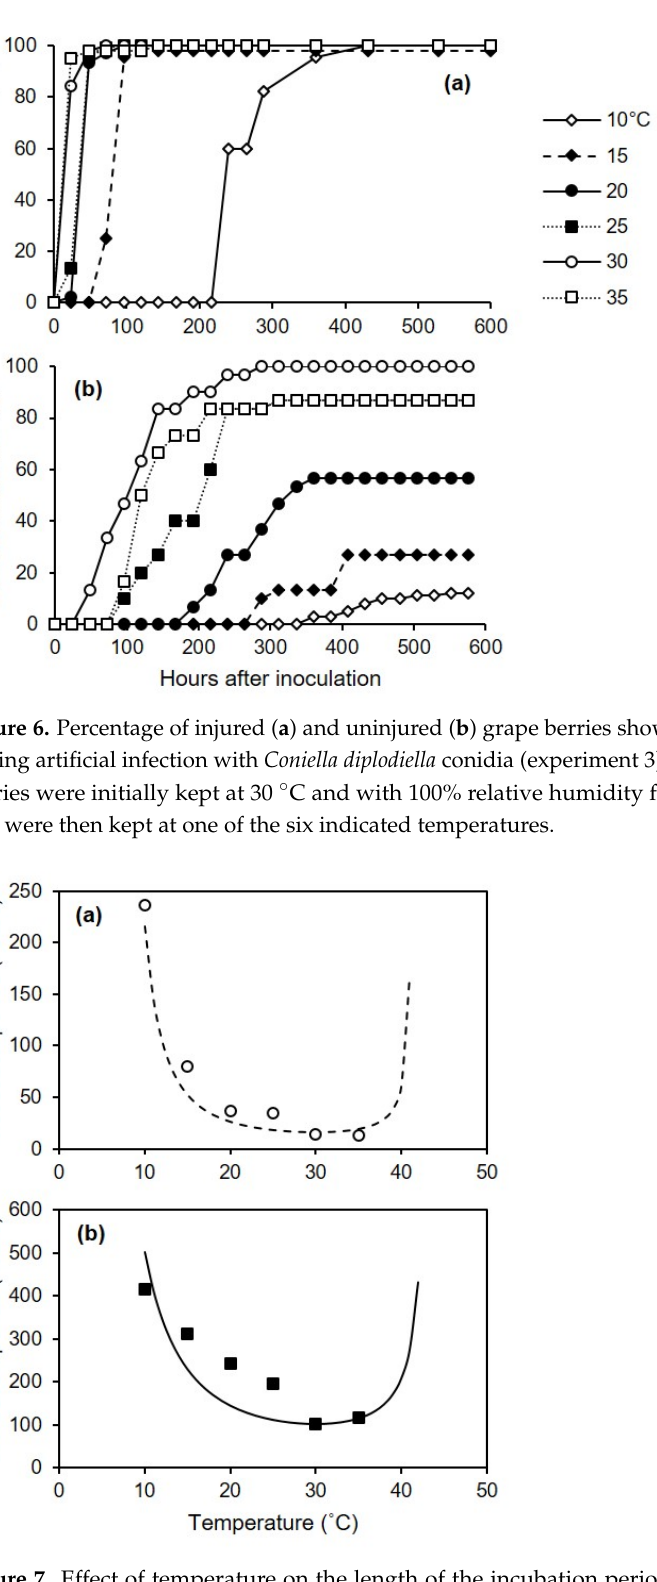
Figure 7. Effect of temperature on the length of the incubation period in grape berries that were injured ( a ) or uninjured ( b ) and artificially inoculated with Coniella diplodiella conidia (experiment 3). After they were inoculated, the berries were kept at 30 °C and with 100% relative humidity for 12 h to facilitate infection, and were subsequently kept at one of the six indicated temperatures. Period lengths were expressed as the number of hours required to reach 50% disease incidence (IP 50 ). The lines show the fit of the data with Equation (5).